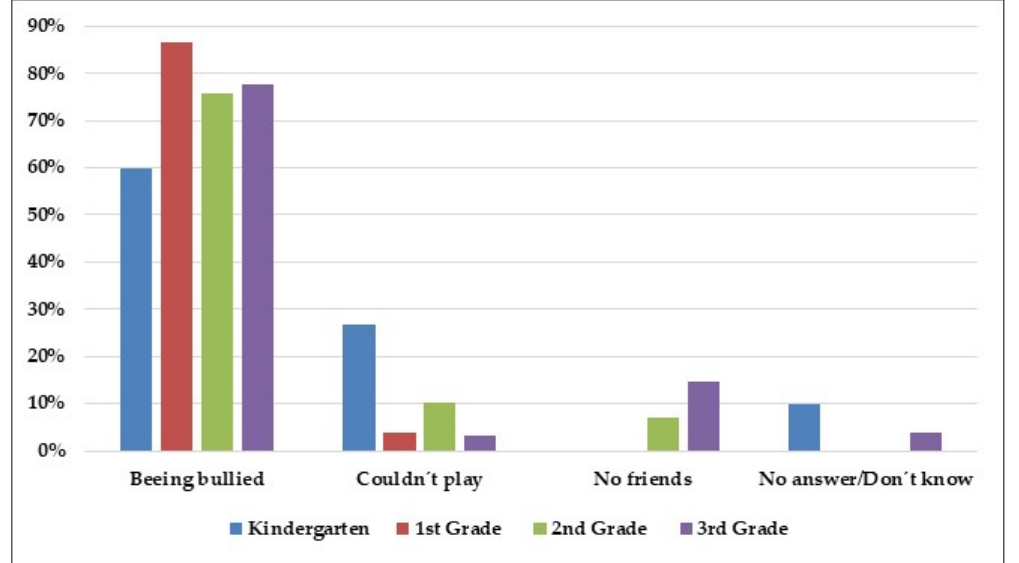
Figure 6. Reason for interviewees´ emotions in place of victims.